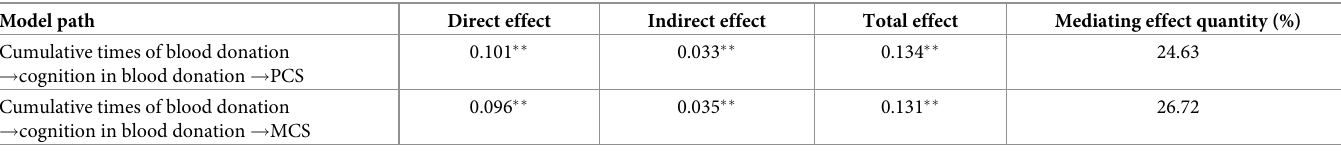
Table 4. Decomposition of effects of blood donation on PCS and MCS. Model